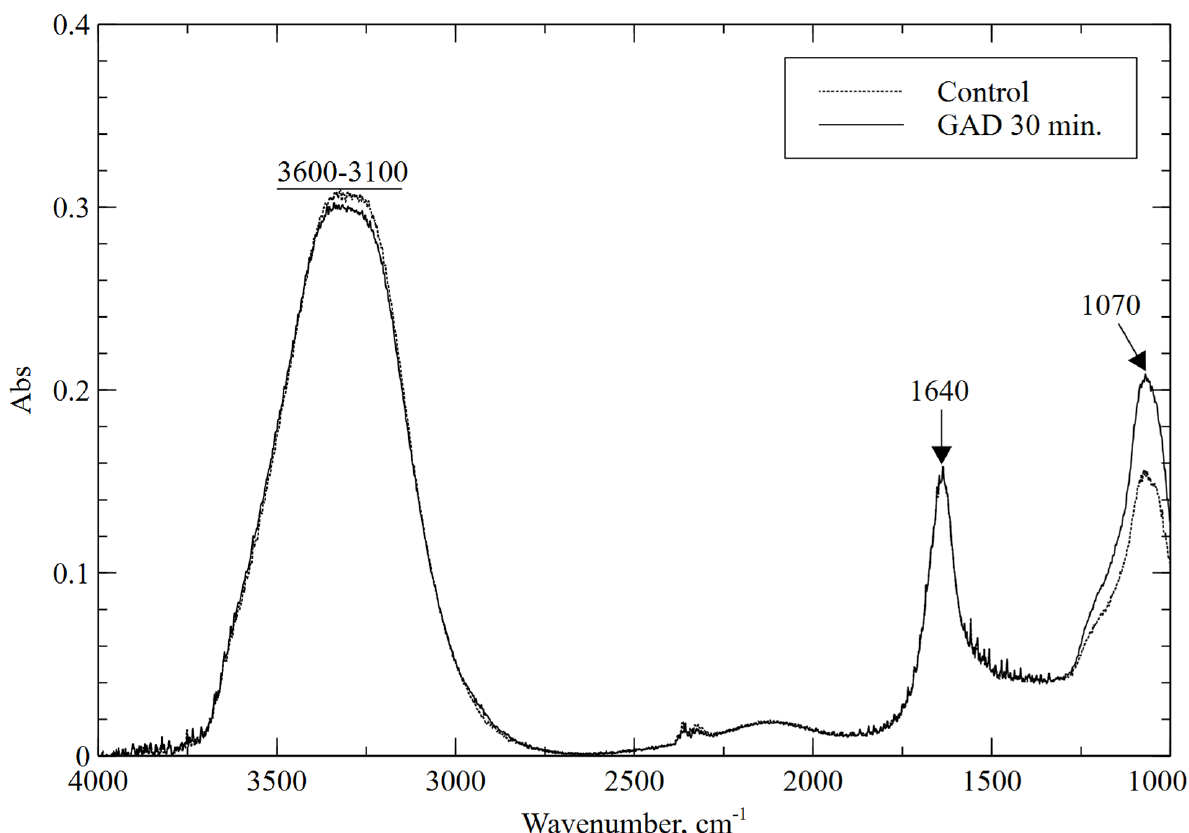
Figure 4. FTIR spectra for the control sample and the 30 min plasma treatment.